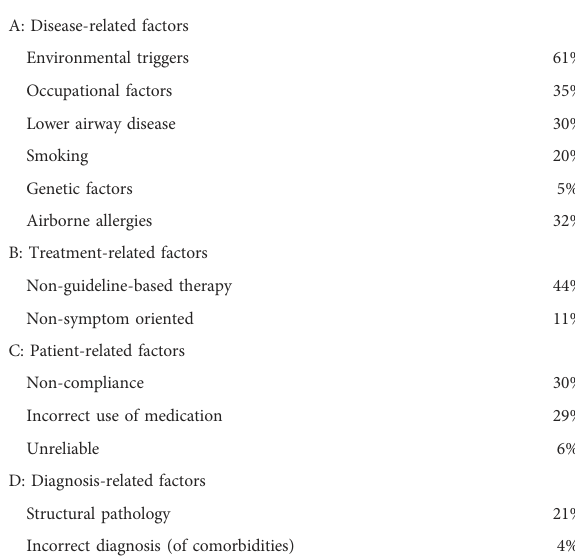
TABLE 3 Reasons for uncontrolled disease.